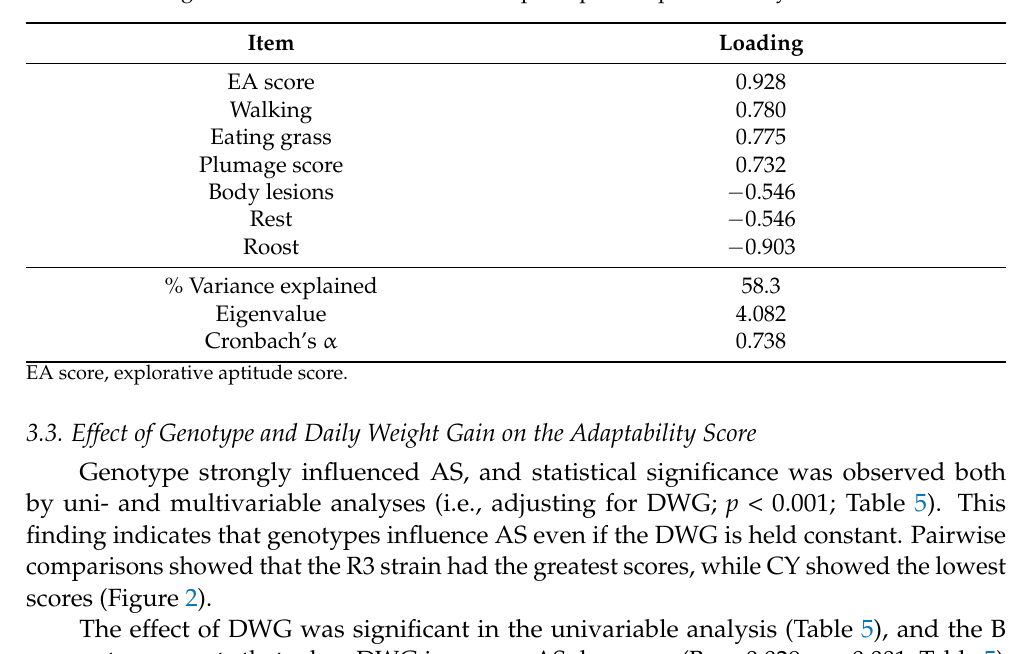
Table 4. Loadings of the variables included in the principal component